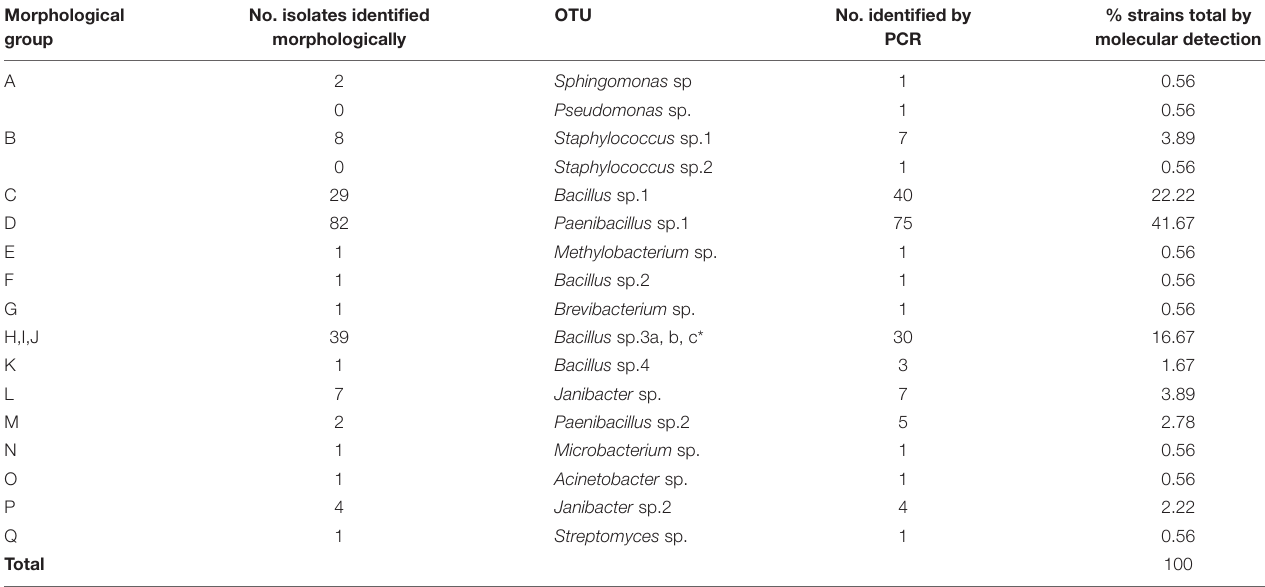
TABLE 4 | Final classification of 180 bacteria isolated from in vitro cultures of Ipomoea batatas. Morphological group